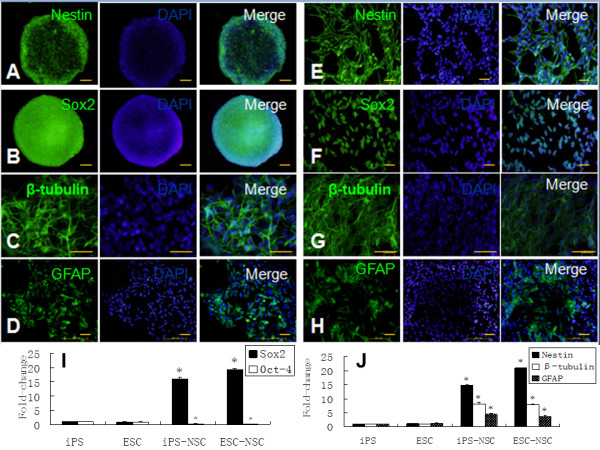
The expression of pluripotent potent and neural markers during the induction process of the iPSCs to NSCs. Immunocytochemistry staining shows that the spheres expressed the neural precursor markers Nestin(A), Sox2(B) induced by RA and serum-free medium, and after culture, in serum medium; those spheres expressed the neuron marker β-tubulin (C) and astrocyte marker GFAP (D). The adherent cells expressed the neural precursor markers Nestin(E), Sox2(F), and differentiated into neurons and astrocytes in the same conditions (G, H). The expression of pluripotent genes Sox2 and Oct4 during the induction process in the iPSCs and ESCs (I); the iPSC-derived NSCs expressed high levels of Nestin, β-tubulin, and GFAP during the induction process and showed a similar tendency to the ESC-derived NSCs (J, *compared with ESCs; P < 0.05).